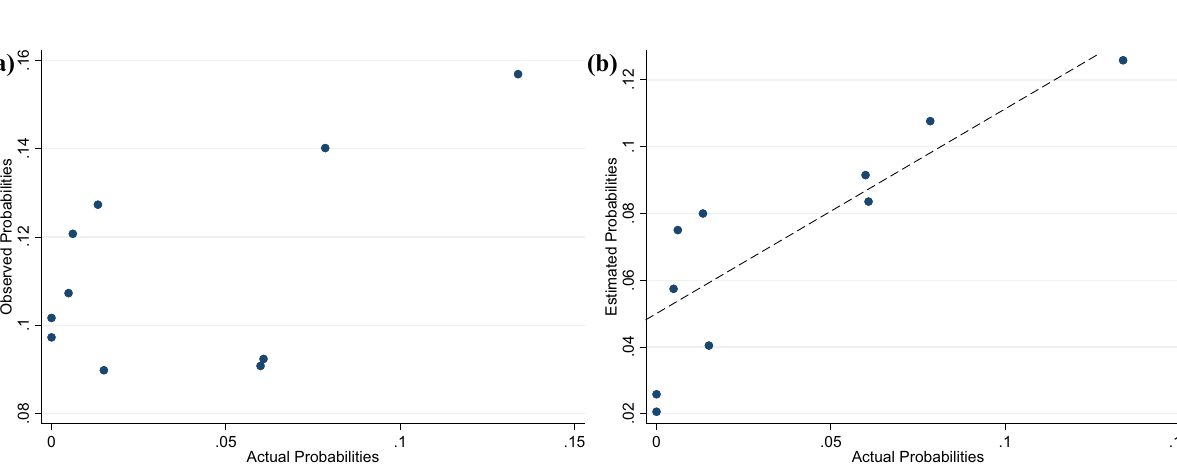
Figure 9. The probability density of the observed probabilities when actual probabilities is zero.